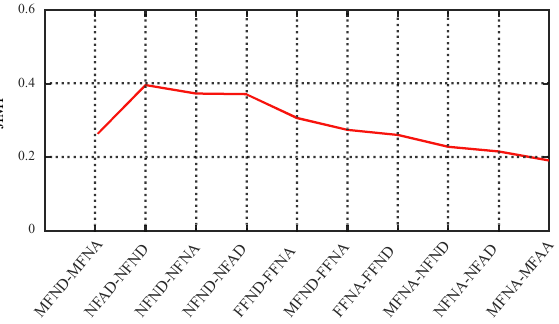
Figure 16. The top ten transition probabilities with the greatest joint mutual information.